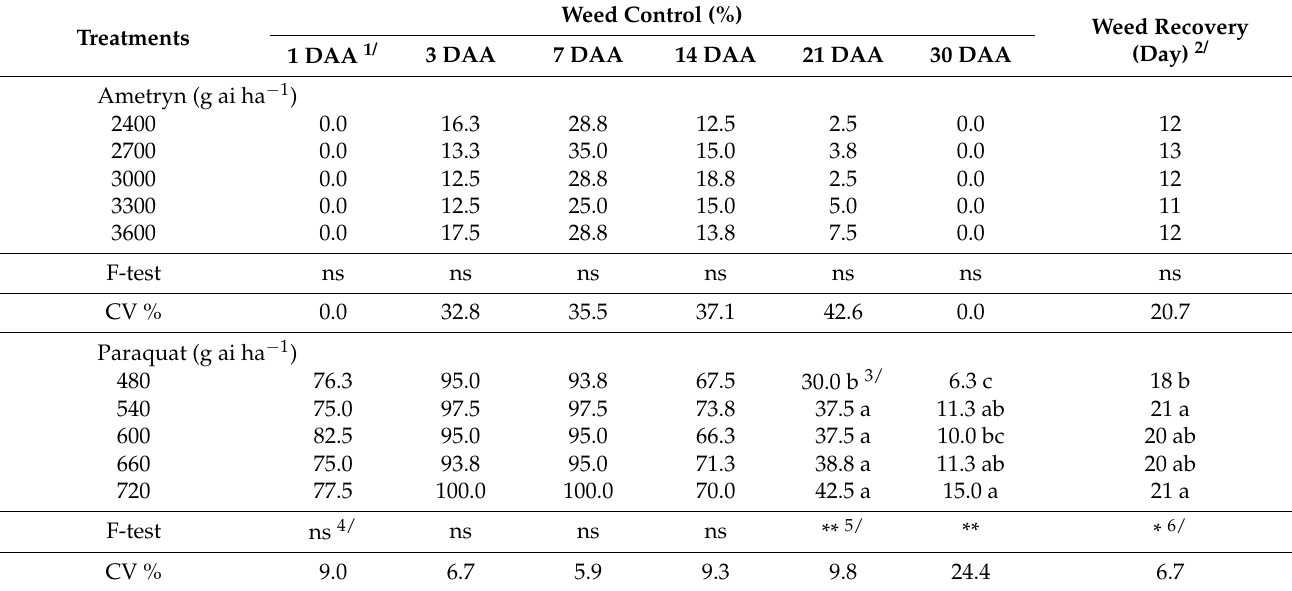
Figure 2. Effects of ametryn and paraquat applications on weed control at 1, 3, 7, 14, 21, and 30 DAA in Experiment I. 1/ days after application. Table 1. Effects of ametryn and paraquat applications at various rates on weed control at 1, 3, 7, 14, 21, and 30 DAA; and weed recovery in Experiment I .